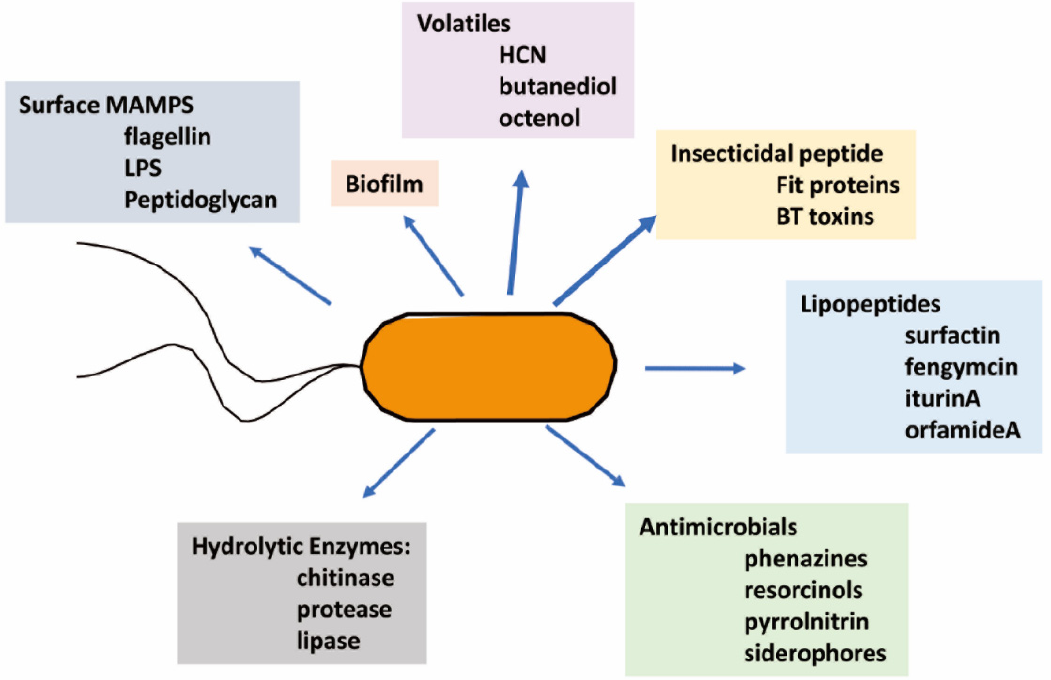
Figure 2. Classes of metabolites involved in biocontrol of microbial, insect, and nematode pests for plants. The biocontrol-active rhizobacteria are highly selective pathogens causing death, or im- paired growth, of plant pests through the production of soluble and volatile metabolites, enzymes, and the formation of biofilms. Additionally, microbially associated molecular patterns (MAMPs) and certain metabolites will trigger plant defense systems.